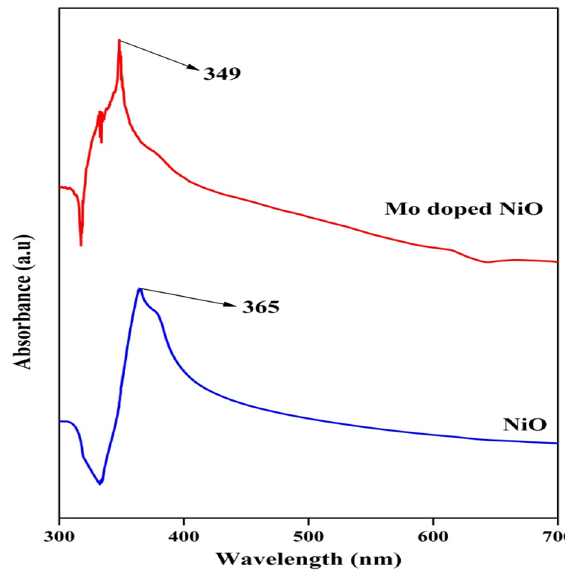
Figure 5. UV–Vis analysis of NiO NPs and Mo doped NiO NPs.